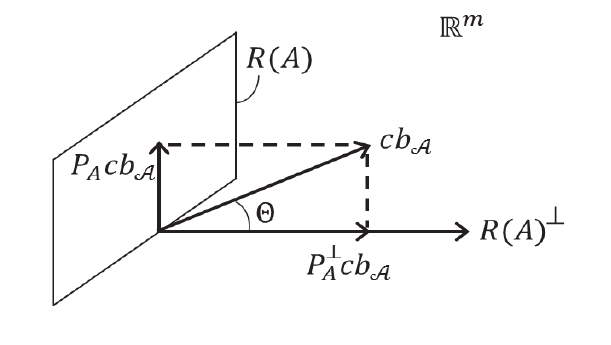
Figure 2. Orthogonal decomposition of cb A into range space of A and its orthogonal complement: c ) b A [7]. cb A = ( P A c + P ⊥ A